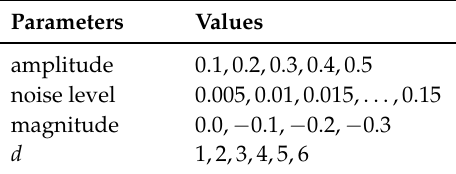
Table 2. Parameters for simulation of vegetation time series: amplitude of the asymmetric Gaussian function, noise level, magnitude of the abrupt change, and number of new observations to quantify detection delay ( d